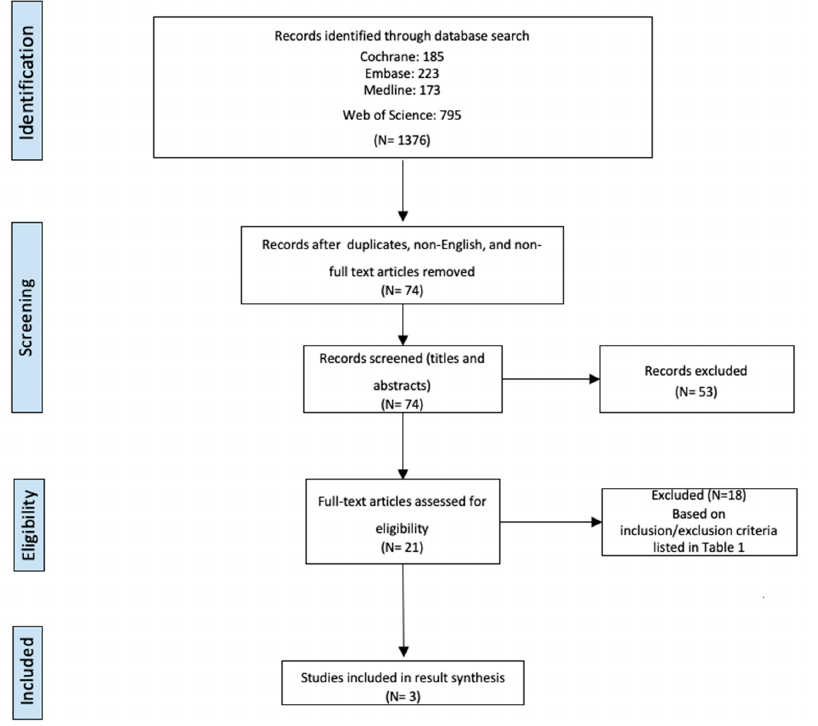
Figure 1. Flowchart of study